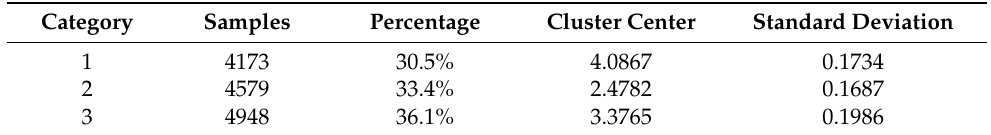
Table 2. Clustering distribution of pupil diameter.